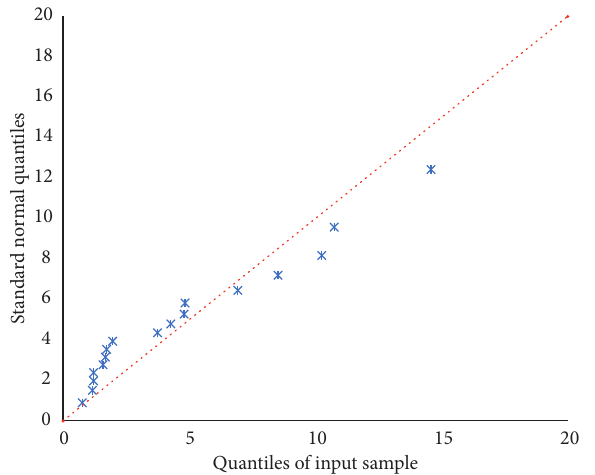
Figure 7: QQ plot of training